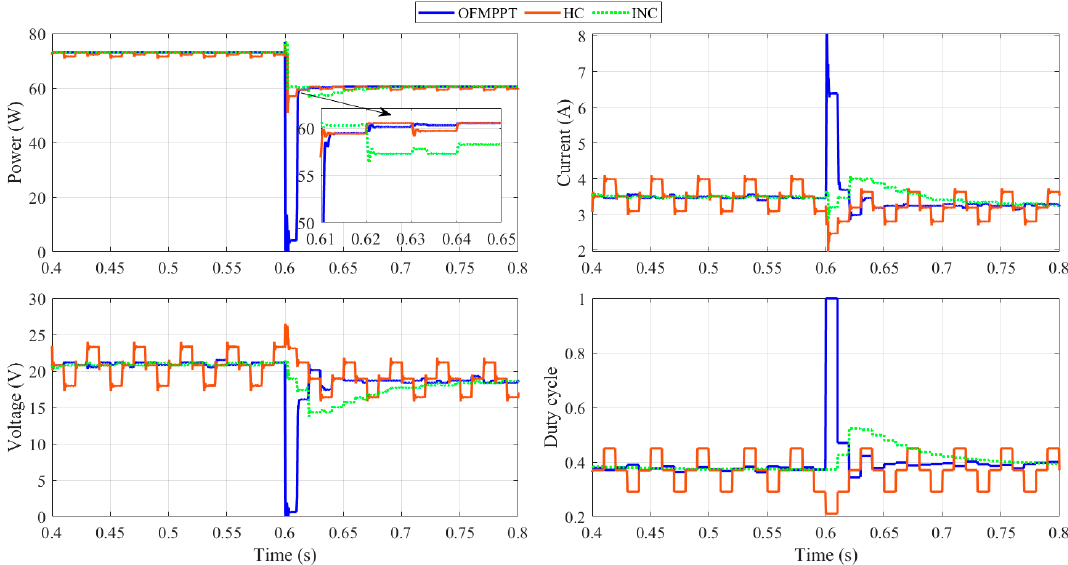
Figure 12. Dynamic tracking performance using OFMPPTS, HC, and INC methods for 3rd scenario.